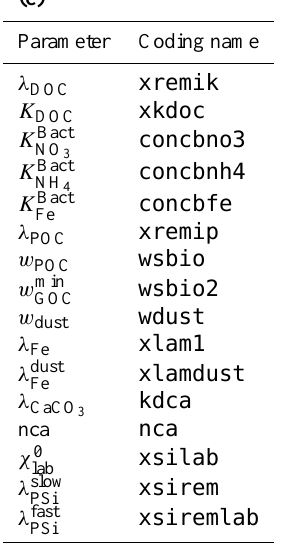
Table A1. (a) Model parameters for phytoplankton with their de- fault values in PISCES. (b) Model parameters for zooplankton with their default values in PISCES. (c) Model parameters for or- ganic and inorganic matter with their default values in PISCES. (d) Model parameters for various processes with their default values in